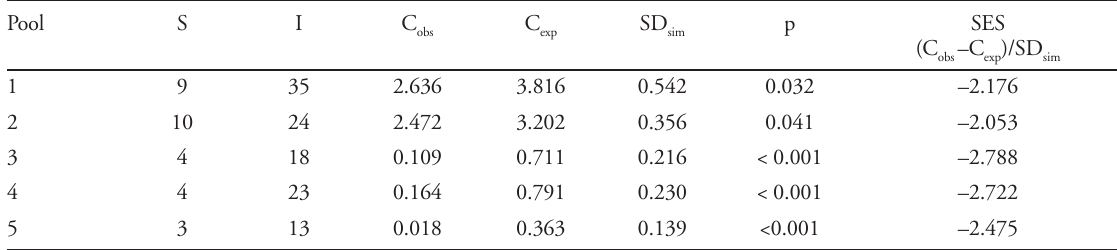
Table 1. Results from the null-model analysis of temporal occurrence of macroinvertebrate on leaf detritus. For each site we report the number of sampled taxa (S), the total number of incidences (I), the observed C-score (C the C-scores of the null matrices), the standard deviation of the null distribution (SD ized effect size (SES).